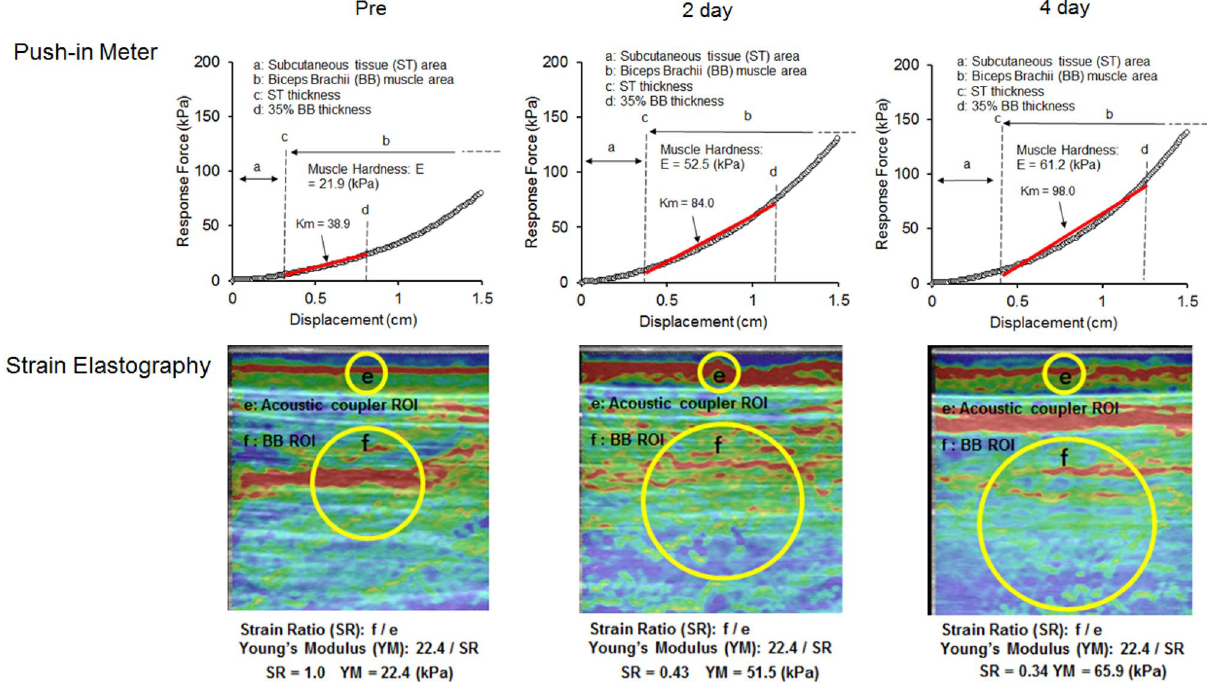
Figure 3. Typical examples of the force displacement relationships measured by push-in meter (PM, upper) and elastography images obtained by strain elastography (SE, lower) for biceps brachii (BB) muscle hardness assessment at before, 2 and 4 days after eccentric exercise. In PM, the force displacement relationship was divided into the subcutaneous area ( a ) and BB area ( b ), then muscle hardness value E was calculated using the slope (Km) of the force curve ranged in 0–35% BB thickness (from c to d ). In SE, the region of interest (ROI) was set for acoustic coupler area ( e ) and a circle including the whole BB ( f ). Using a built-in software, strain ratio (SR) was calculated for each image as a ratio of strain of the muscle ( f ) divided by the strain of the acoustic coupler (e), then SR was converted to Young’s Modulus from the known Young’s modulus of the coupler (22.6 kPa) by the formula; 22.6/SR. (Microsoft Powerpoint 2019, https:// www. micro soft. com/ ja- jp/ micro soft- 365/ power However, in the comparison between ECC and CON, since the relaxed elbow joint angles were different among participants and affected by the exercises differently, the fully extended elbow joint position was used. Push‑in meter (PM). Muscle hardness was assessed using the force–displacement relationship which was recorded by a PM system (TK-HS100, Tokushu-keisoku, Japan). The PM system was described in detail in the previously published papers 13,20 . Briefly, based on a two-layered spring model by Horikawa et al. 12 , the relation between the depth of deformation (displacement) and the reaction force was divided into subcutaneous and muscle component based on the subcutaneous tissue thickness measured by a B-mode ultrasound. The probe angle in the PM assessment was always set vertical to the muscle 20 , thus the effect of the subcutaneous tissue thickness on the muscle harness measures was minimum. The muscle hardness value (E) was calculated by the following equation; E = Id (1-μ 2 ) Km, where I is an influence coefficient, d is the diameter of the probe, μ is Pois- son’s ratio and Km is the slope of the muscle component obtained from the force–displacement relationship. Therefore, E is depended on Km; however, since the force–displacement relationship shows a non-linearity that increases as indentation goes deeper, Km overestimation is likely to occur. To avoid this, the individual muscle thickness was considered. We proposed that the range for Km calculation in the force–displacement curve was normalized by the individual muscle thickness within 40% muscle thickness 20 . In the present study, E was calcu- lated using the slope of the force curve ranged in 0–35% of a biceps brachii muscle thickness of each participant. The typical samples of the force–displacement relationship and Km slope are shown in Fig. 3. Strain elastography (SE). A diagnostic ultrasound system with elastography function (Prosound F75; Hitachi Aloka Medical, Japan) was used. SE evaluates the stress–strain relationship for the tissue hardness based on Hooke’s law applying the compression by the ultrasound transducer. The investigator placed the transducer along the longitudinal axis of muscle with the measurement point on the biceps brachii mid-belly in the centre and manually applied rhythmical compression-relaxation cycles to the muscle with consistent pressure. It was ensured that the transducer was pressed to the strain level of 2 or 3 while monitoring the level shown in the sys- tem screen, and the transducer angle was always perpendicular to the muscle belly, where as indicated by a mark on the skin 13 . Elastograph images were recorded while gently pressing a transducer with a reference material (acoustic coupler, Young’s modulus = 22.6 kPa: EZU-TECPL1, Hitachi Aloka Medical Japan). A circular region